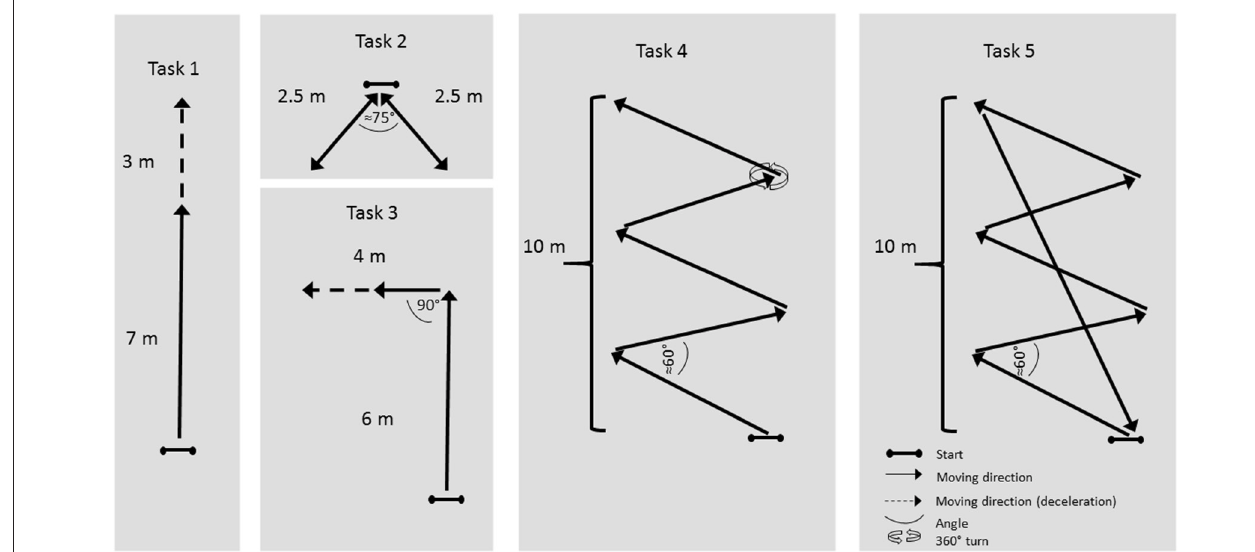
FIGURE 1 | Diagram of the tasks.